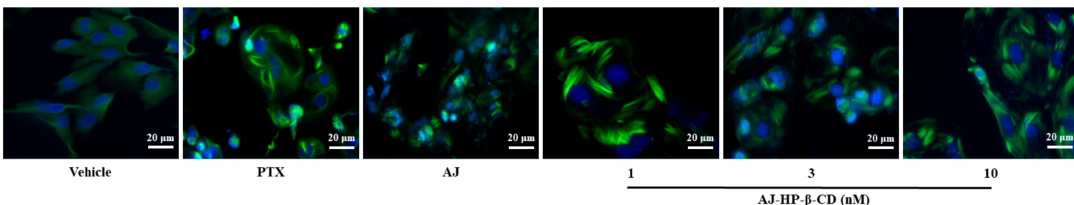
Figure 4. E ff ect of AJ-HP- β -CD on microtubules in 786-O cells. Images were overlaid electronically after cells were examined by fluorescence microscopy, and representative pictures were taken after 24 h. PTX (10 nM), AJ (10 nM), and AJ-HP- β -CD (1, 3, 10 nM).